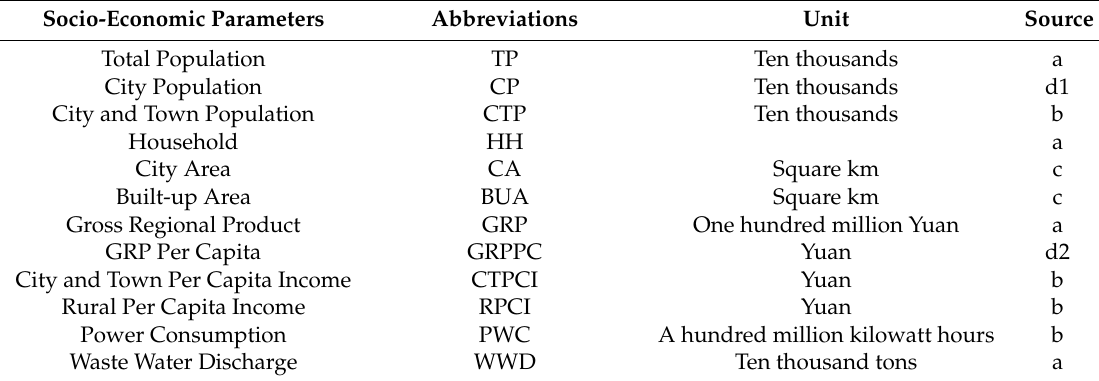
Table 3. The abbreviations, sources and units of socio-economic parameters at the provincial level used in this